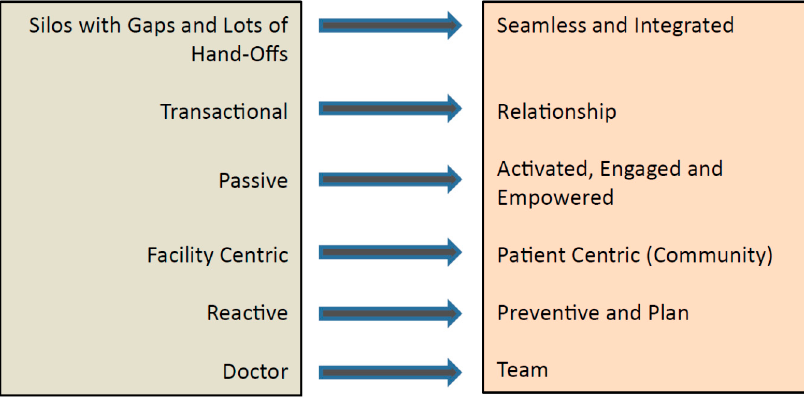
Figure 1. Paradigm shift in healthcare delivery.